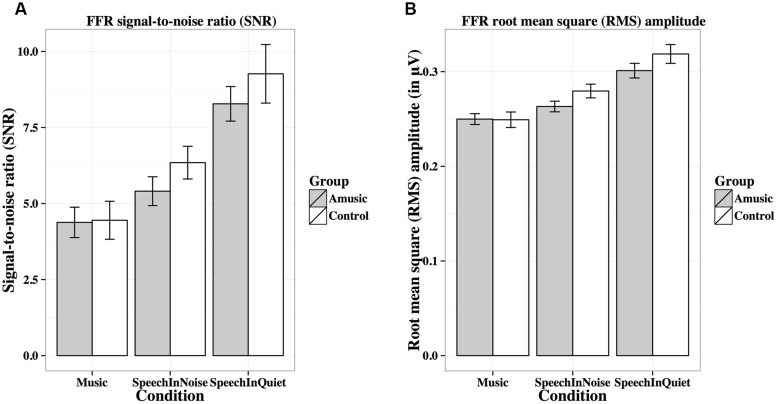
Frequency-following response signal-to-noise ratios (A; SNRs) and root-mean-square (B; RMS) amplitudes (in μV) of amusics and controls under the three experimental conditions.